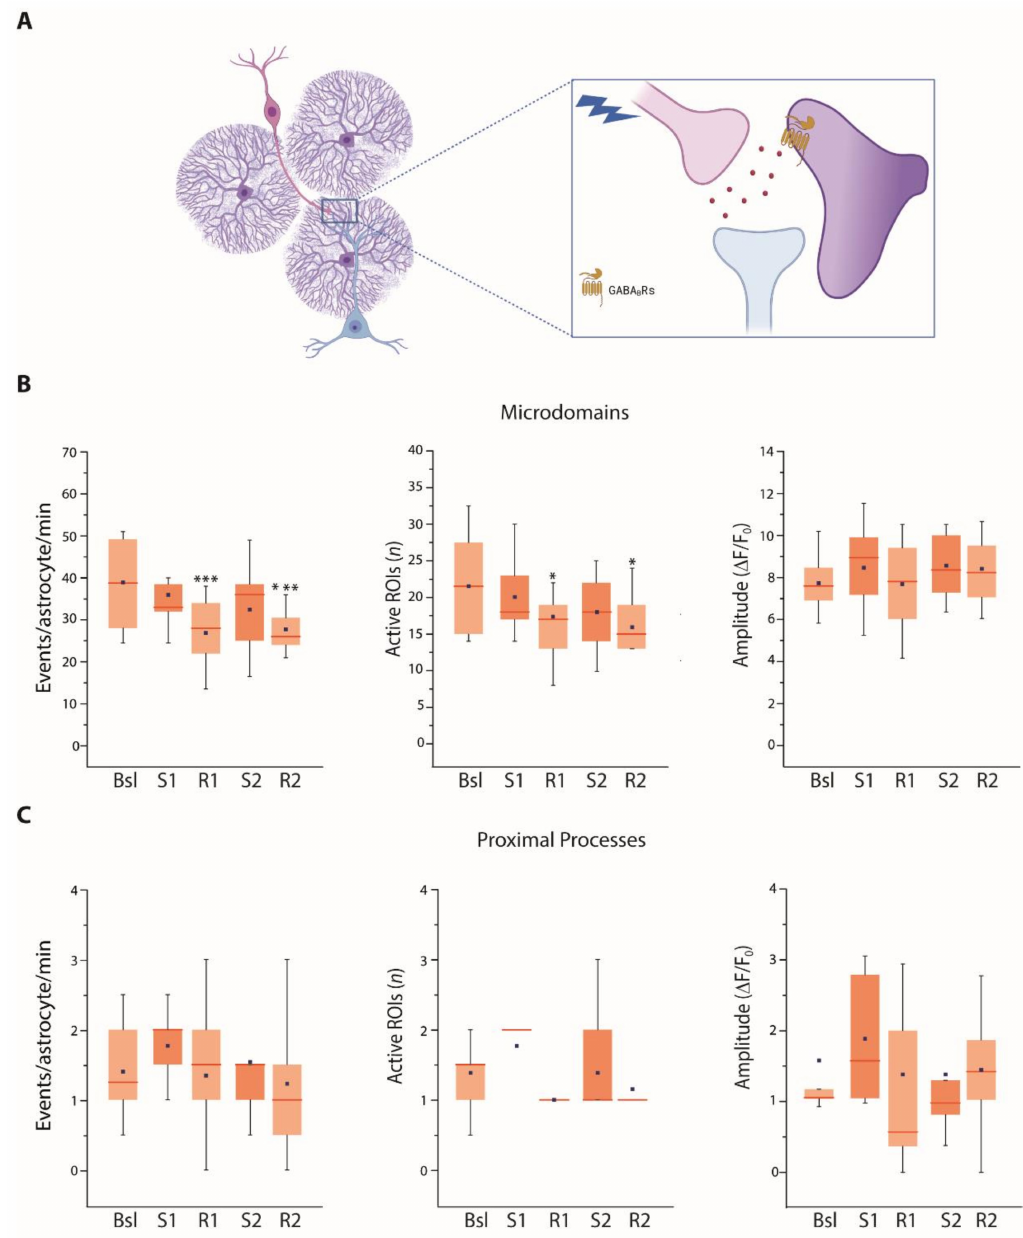
Figure 4. Astrocyte Ca 2+ response to SST interneuron stimulation is mediated by GABA B Rs. ( A ) Scheme showing the hypothesis that VCx astrocyte Ca 2+ response to SST interneuron stimulation is mediated by GABA B R activation. ( B ) Average data of Ca 2+ signal dynamics at microdomains (5430 total events) in the presence of the GABA B R antagonist CGP 55845 (13 astrocytes, 8 slices, 4 mice). ( C ) Average data of Ca 2+ signal dynamics at proximal processes (234 total events) in the presence of CGP 55845 (13 astrocytes, 8 slices, 4 mice). * p < 0.05, *** p < 0.001, One-way repeated measures